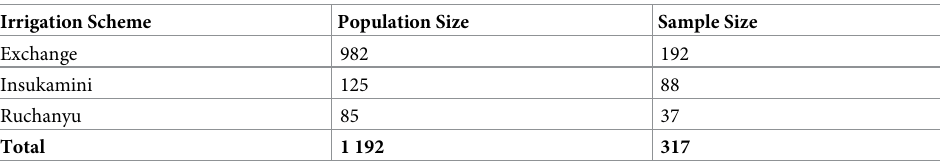
Table 2. Sampling design.